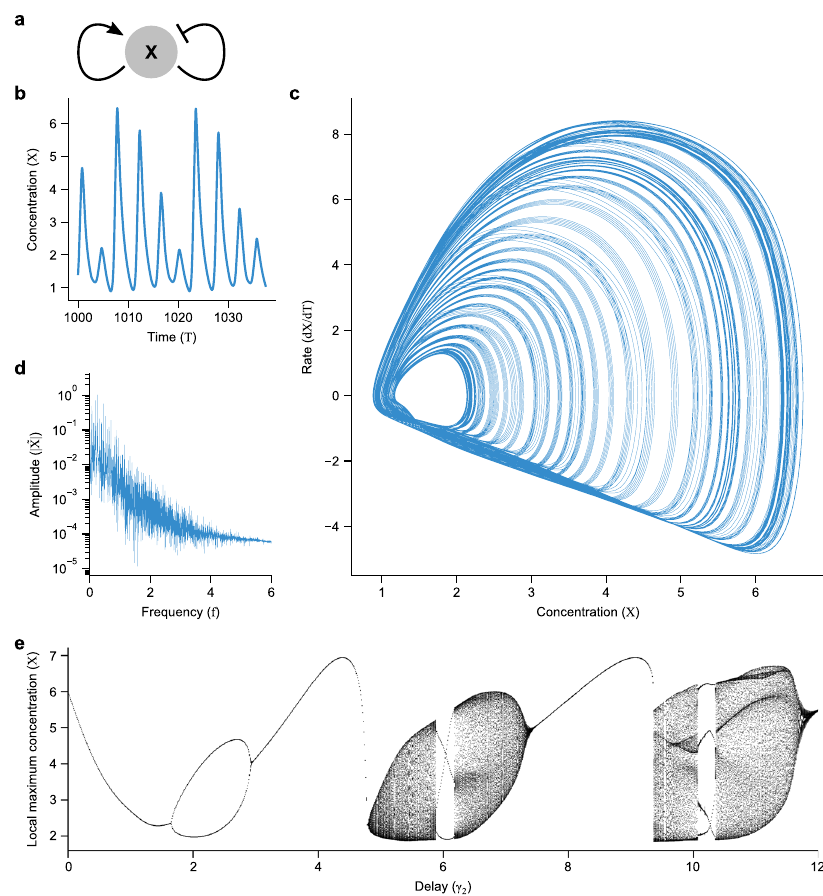
Fig. 8 Positive/negative dual feedback can induce chaotic behavior when the difference in delay times is signi fi cant. a The double feedback motif, in which two regulation arms feed back directly, each with its own explicit delay. Here we show one arm activating and one repressing; for double repressive feedback, see Supplementary Fig. 5. b Time trace of chaotic dynamics after initial transients. c Trace of dynamics in phase space, with the derivative on the vertical axis. While a simple oscillator would trace a loop (possibly with multiple sub-loops if the waveform is complicated), the chaotic dynamics appear to trace out a fractal attractor. Consistent with chaos, a reconstructed phase space with coordinates ( X ( T ), X ( T − 10), X ( T − 20)) traces out a fractal attractor, with box dimension 1.81 with 95% con fi dence interval (1.76, 1.87) and a positive dominant Lyapunov exponent (0.0040 ± 0.00055 bits), see “ Methods ” for details. d Fourier transform of chaotic dynamics show many peaks, indicating that there is no simple set of frequencies underlying the dynamics. e Bifurcation diagram for double positive/negative feedback, with local maxima plotted. Simple oscillations intersperse regimes with complex dynamics, where local maxima with a range of values are found. η 1 = 15, η 2 = 1, n 1 = 11, n 2 = − 3, and γ 1 = 1. For ( b – d ), γ 2 =